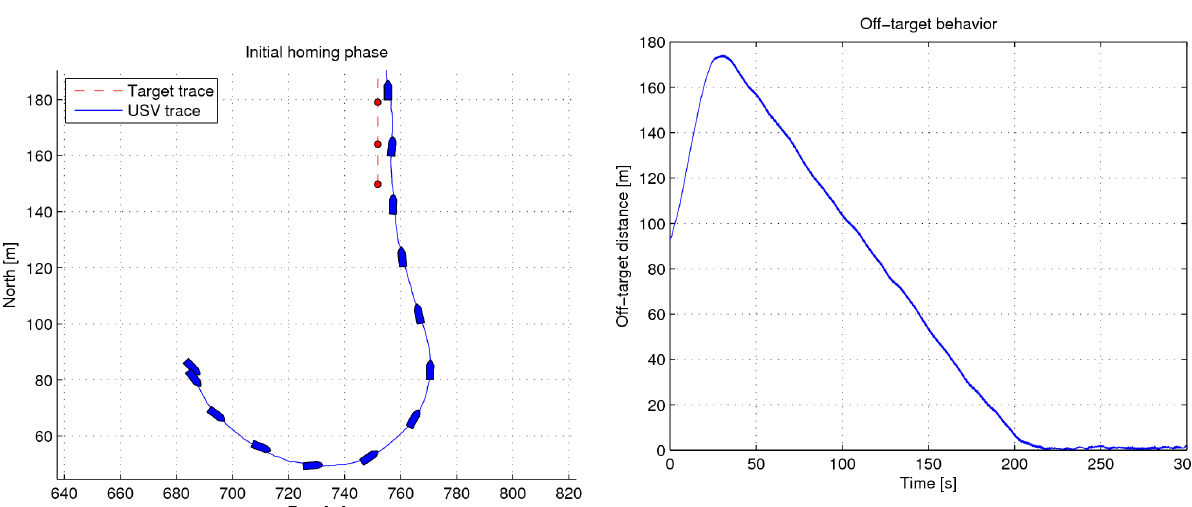
Figure 13: The USV is maneuvering onto an intercept course with the target.